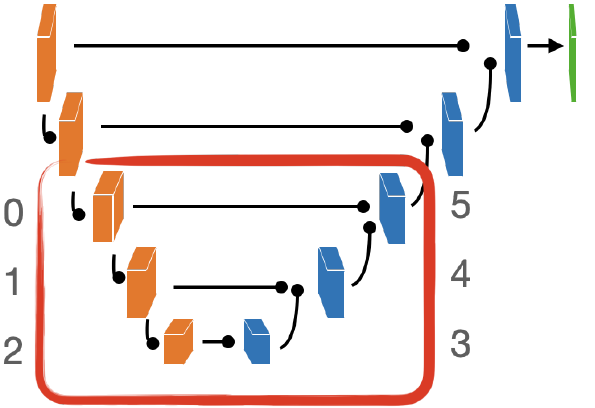
Figure 17. Graphical representation of the EUNet architecture. In the red encircling, the 6 inner blocks computing the Intrinsic Dimensionality at different stages of the training process using the TwoNN